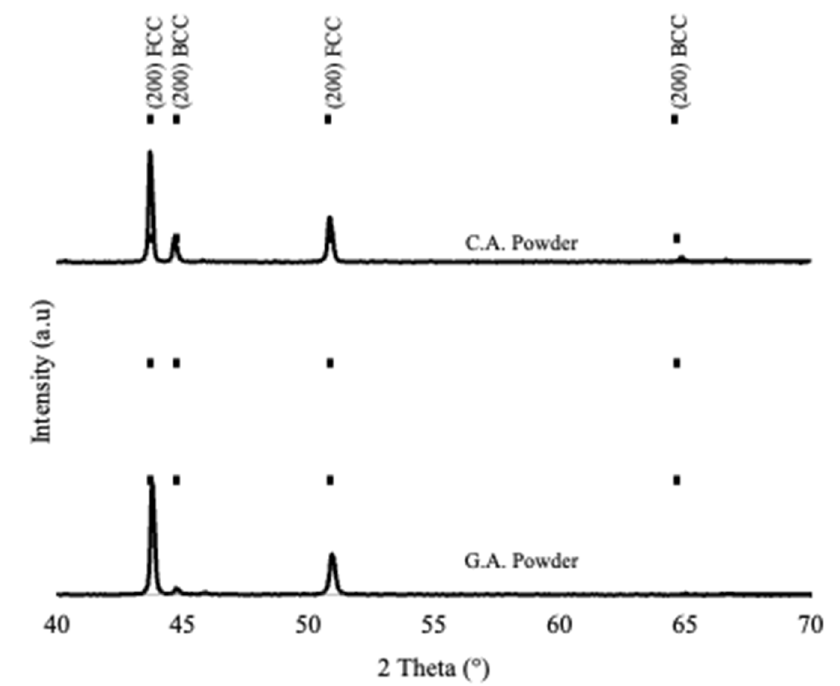
Figure 7. XRD spectrum of as ‐ received powders.